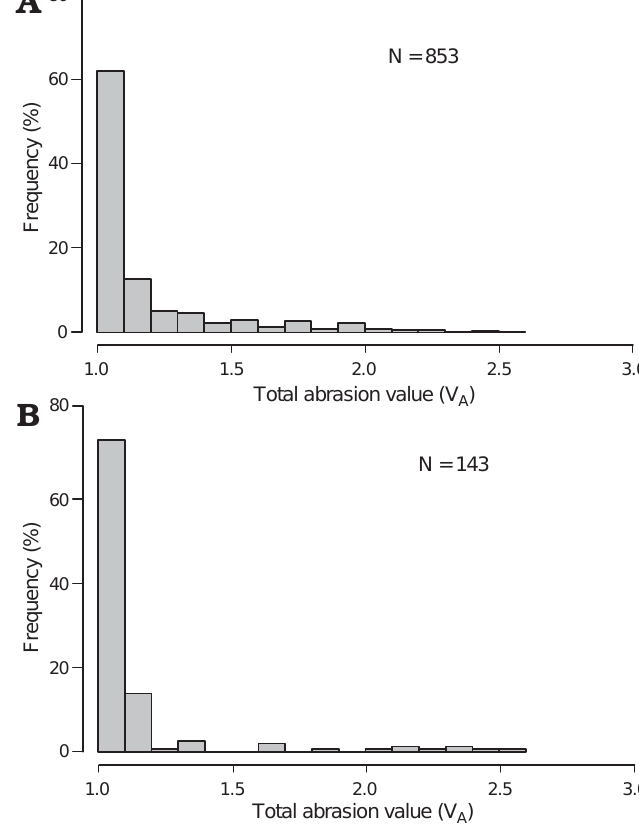
Fig. 6. Histograms of undrilled ( A ) and drilled ( B ) tests of Echinocyamus pusillus with respect to the total abrasion value. N, number of